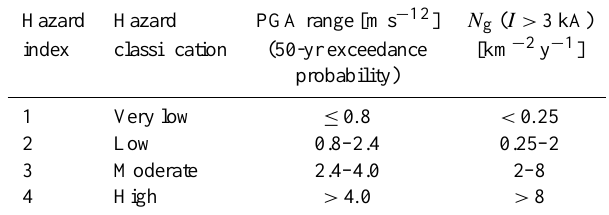
Table 3. Seismic hazard classification adopted by the Global Seis- mic Hazard Assessment Program (ESPON, 2006) and lightning hazard classification in terms of annual frequency per square kilo- metre ( N g